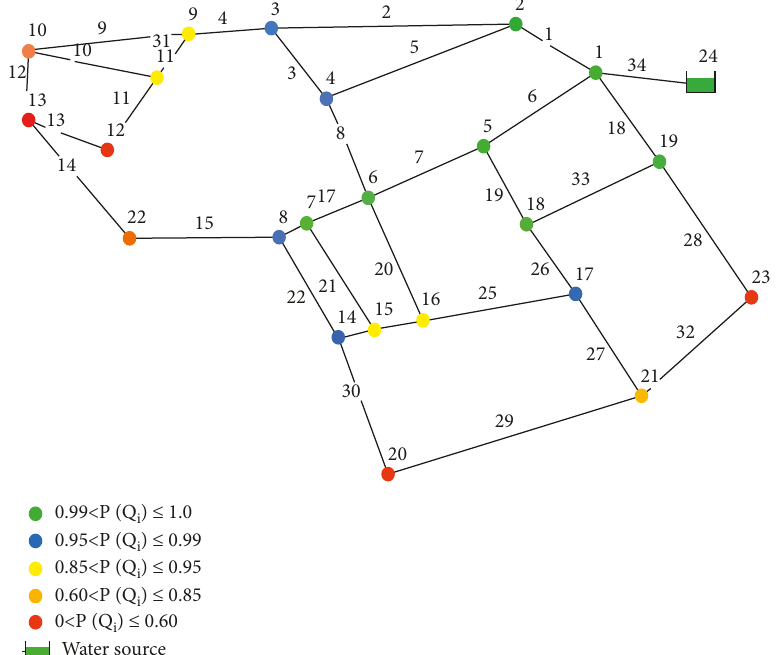
Figure 9: Spatial distribution of node reliability of Apulian water supply pipe network (cast iron pipe) after moderate liquefaction earthquake with IX